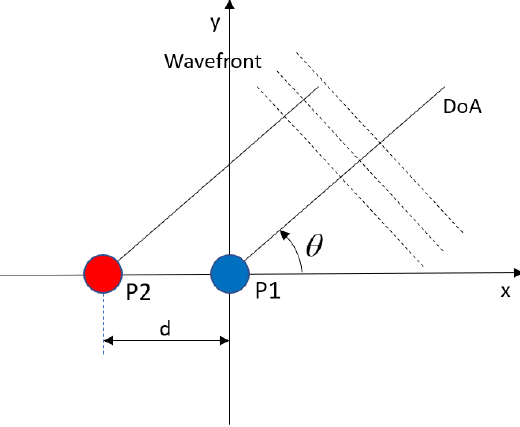
Figure 1. A basic cluster of two circular piezo-sensors spaced apart by a distance d